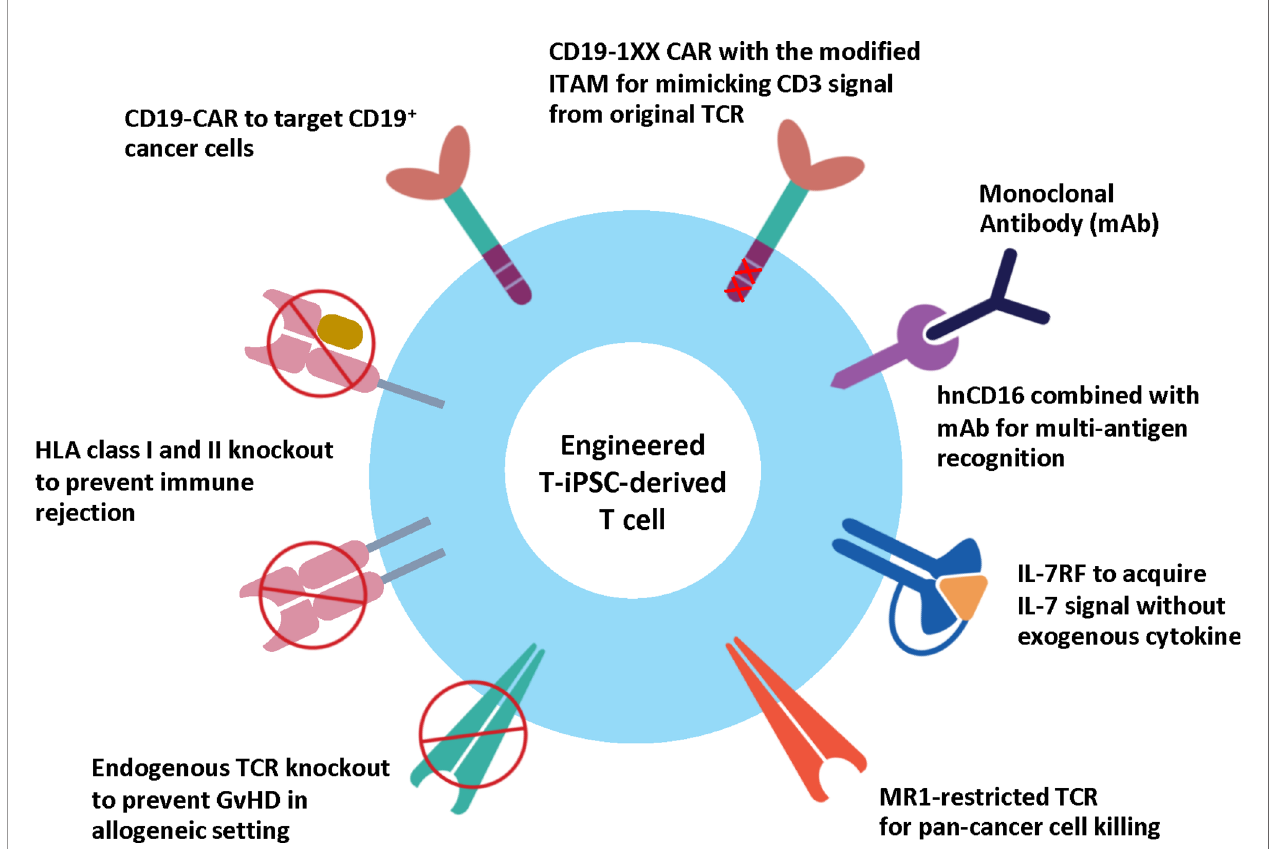
FIGURE 3 | Engineered T-iPSC-derived T cells for next-generation ACT. Genome editing technologies can be used to eliminate the endogenous TCR to reduce the risk of graft-versus-host-disease (GvHD) or HLA molecules to reduce the risk of immune rejection for allogeneic use, or to introduce CAR to speci fi cally target cancer cells. However, the conventional CAR with three ITAM motifs generates higher CD3 signals than endogenous TCR and results in altered T cell differentiation of iPSCs. CD19-1XX CAR construct is the novel CAR construct with mutated second and third ITAM motifs to reduce the CD3 signal. Apart from CAR, the iPSC-derived T cells can be modi fi ed to express MR1-restricted TCR to target a wide range of cancer cells. Other strategies to enhance cytotoxic activity and persistence include the expression of hnCD16 and IL-7